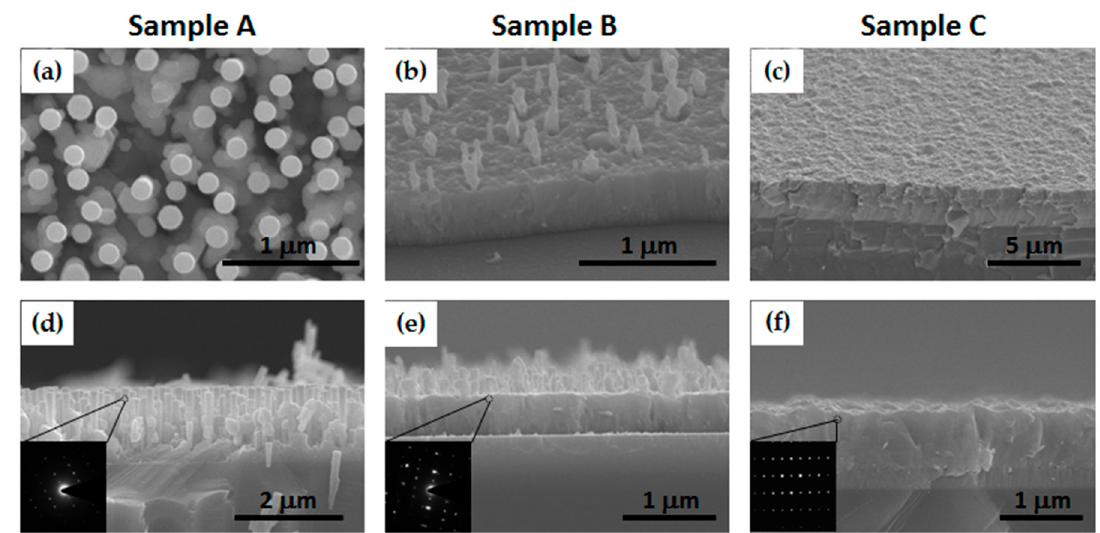
Figure 1. Scanning electron microscopy images of sample A, B and C; ( a – c ) top-view images, ( d – f ) cross-sectional images of sample A, B, and C, respectively. (Inserts: corresponding selected area electron diffraction (SAED) patterns).